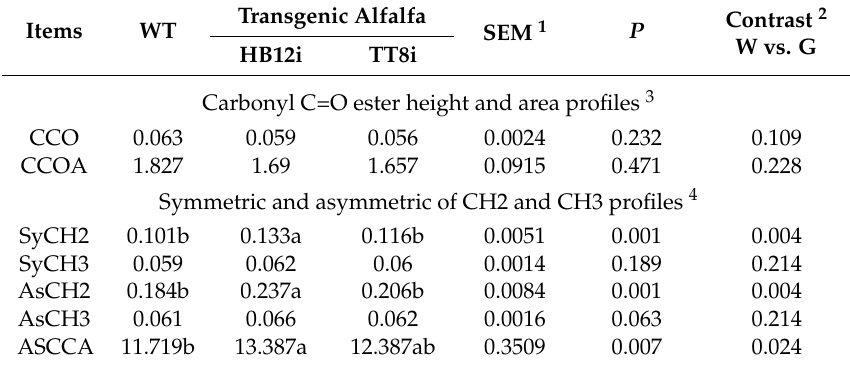
Table 3. Lipid-related structural parameters of transgenic and wild type (WT)